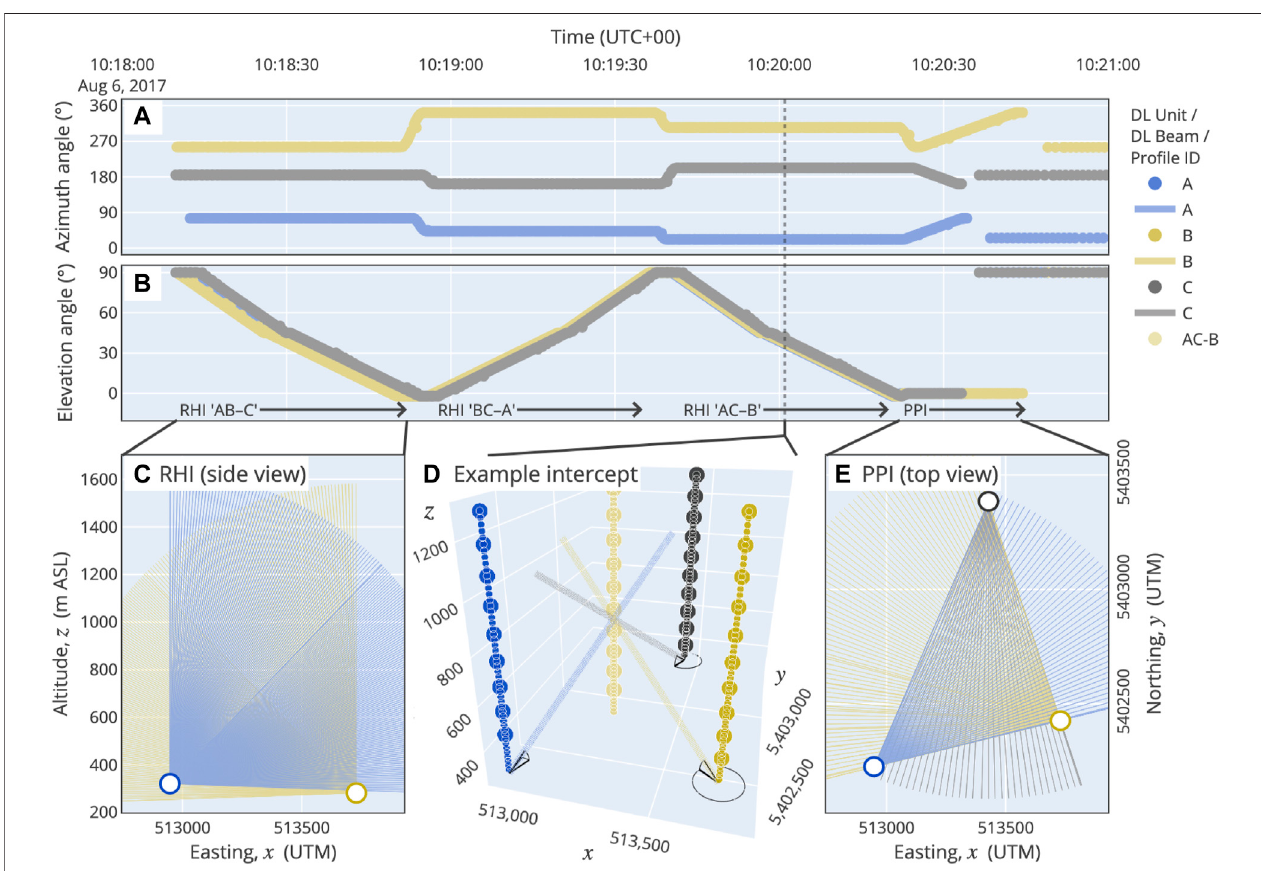
FIGURE3| Foran exampleDoppler lidar(DL) scan routine areshown thepolar angles in (A) azimuth and (B) elevation, whichincludes (C) arange-heightindicator (RHI) co-axial plane scan, (D) three-dimensional vertical pro fi le intercepts and (E) a plan-position indicator (PPI) co-axial plane scan between DL units “ A, ” “ B ” and “ C. ” See text for details.